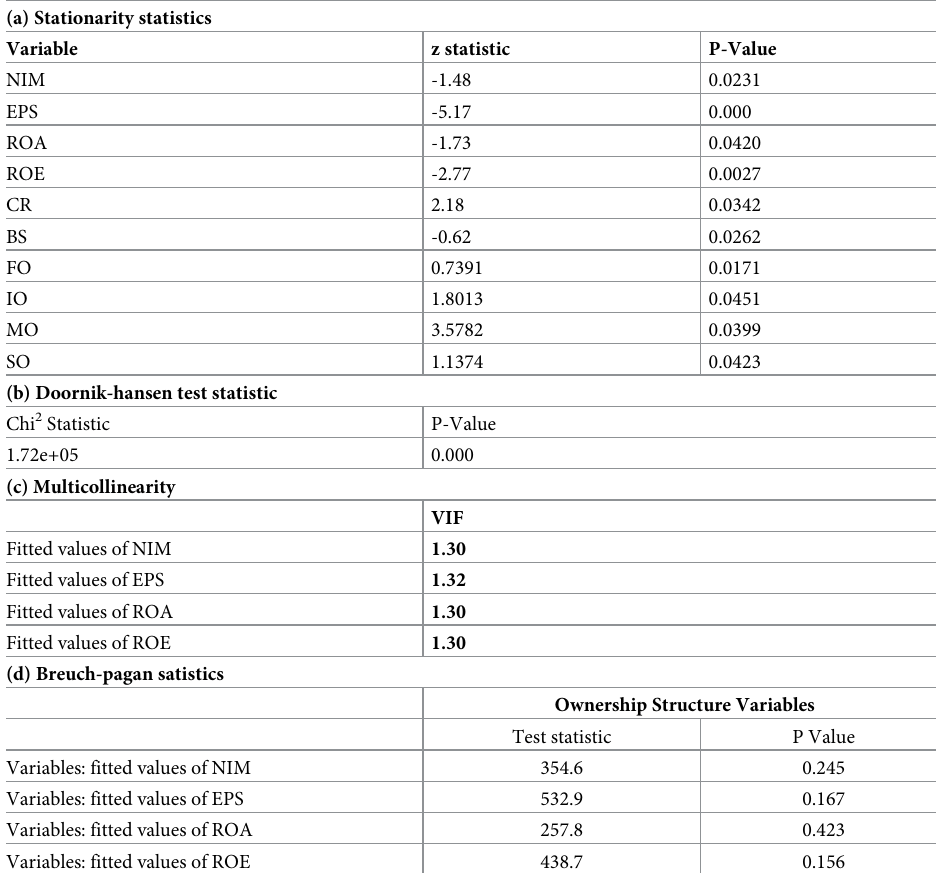
Table 3. Diagnostic